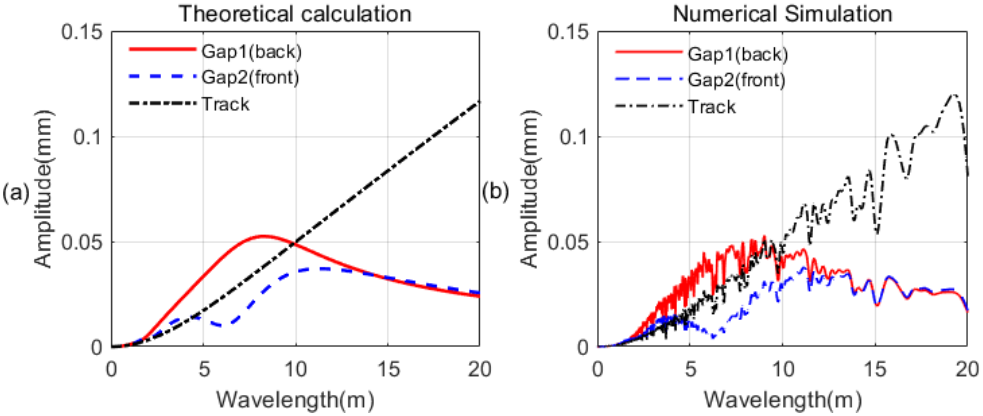
Figure 9. Amplitude spectrums of levitation gap errors at 80 km/h. ( a ) Theoretical calculation, ( b ) numerical